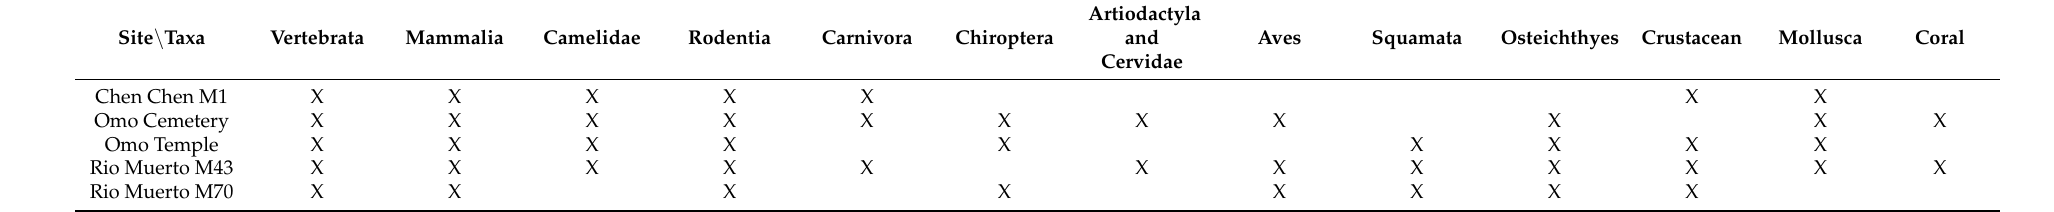
Table 3. Non-anuran taxa present in analyzed site